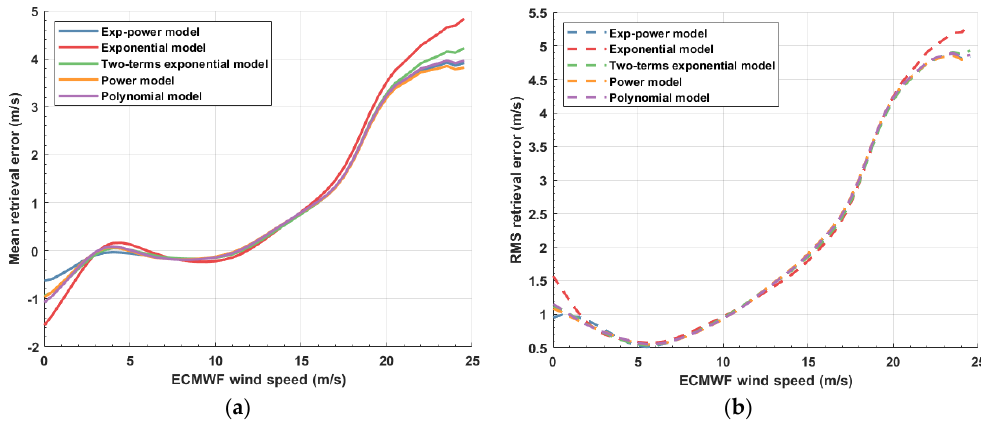
Figure 10. ( a ) Mean error curves and ( b ) root-mean square (RMS) error curves for the retrieved wind speed using different models on test data. speed using di ff erent models on test data.